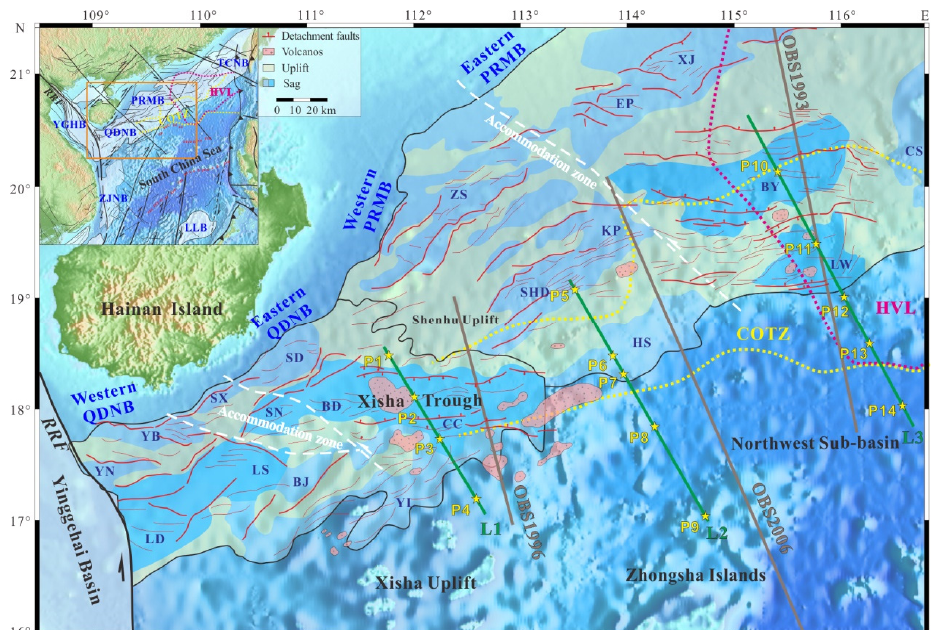
Figure 1. Tectonic map of the northwestern SCS, including the QDNB and eastern PRMB. The green solid lines (L1, L2, and L3) denote the locations of multi-channel seismic reflection profiles, which were used to examine the thermo-rheological structures [14,25,26]. The thermo-rheological structure along profile L1 has been constructed in the previous research [36]. The brown lines indicate the ocean bottom seismometer profiles of OBS1993, OBS1996, and OBS2006, which are from Qiu et al. [37], Yan et al. [18], and Ding et al. [12]. Yellow dotted lines and red dotted lines represent the distribution range of COTZ and HVLs in the lower crust, respectively [22,23]. Yellow stars of P1-P14 show the locations of calculated typical lithospheric rheological structures. BY, Baiyun Sag; BJ, Beijiao